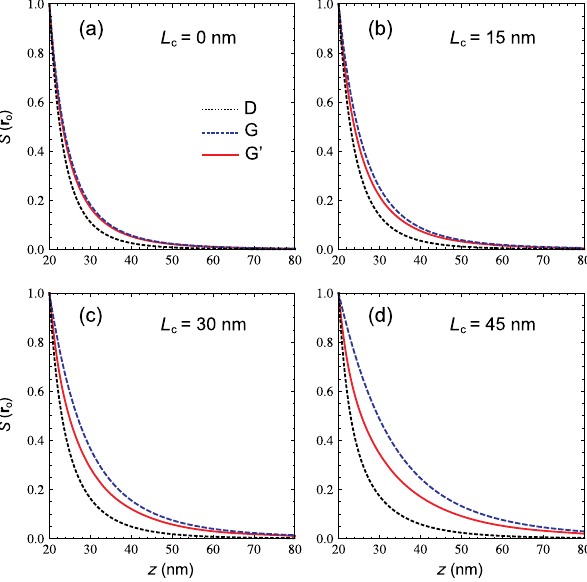
FIG. 11. Distance dependence of the TST þ ST signals for the 10. Distance dependence of the ST signal for the D D, G, and G 0 bands. Panels (a-d) account for different values of band. Panels (a-d) account for different values of L : 0, 15, 30, c L : 0, 15, 30, and 45 nm, respectively, as indicated in the and 45 nm, respectively, as indicated in the graphics. In all c ~ f 3 and r 15 nm. The signal S ð r graphics. In all cases, we used cases, we set 0 Þ is e ¼ tip ¼ 20 signal S ð r 0 Þ is normalized to 1 at z normalized to 1 at z min ¼